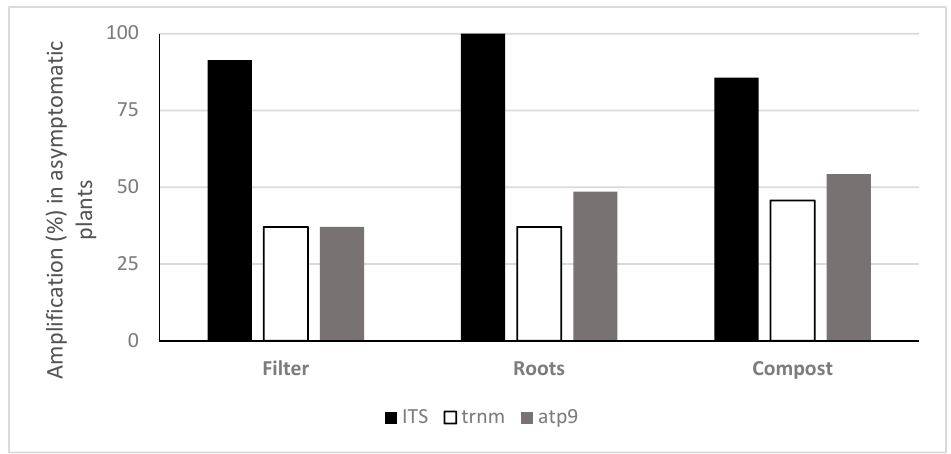
Figure 5. Frequency of detection of oomycete eDNA using TaqMan probes in asymptomatic plants.